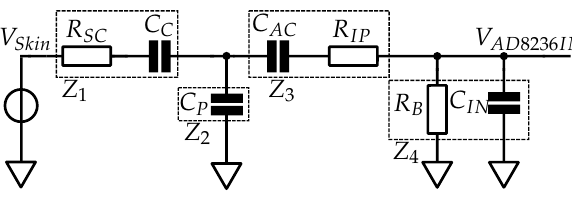
Figure 10. Equivalent circuit diagram of the input stage used for the transfer function to calculate the coupled signal